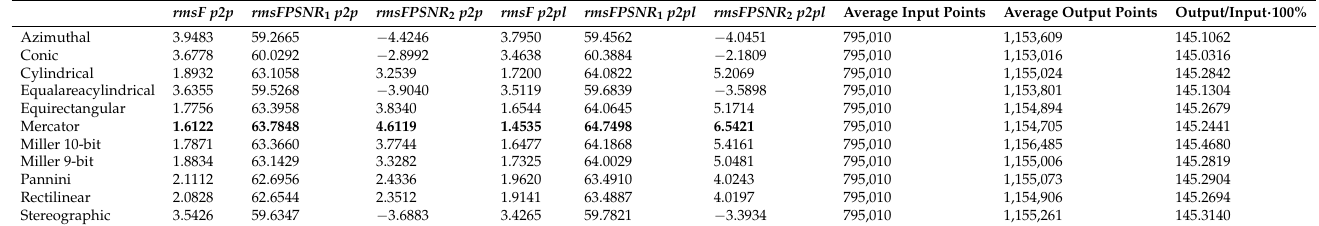
Table 7. Point-to-point (p2p) and point-to-plane (p2pl) objective measures rmsF , rmsFPSNR 1 and rmsFPSNR 2 , after Poisson reconstruction, using different projections with projection area of 1056 × 944 pixels (approximately 1,000,000), best values are bold; average input and output number of points and their ratio.